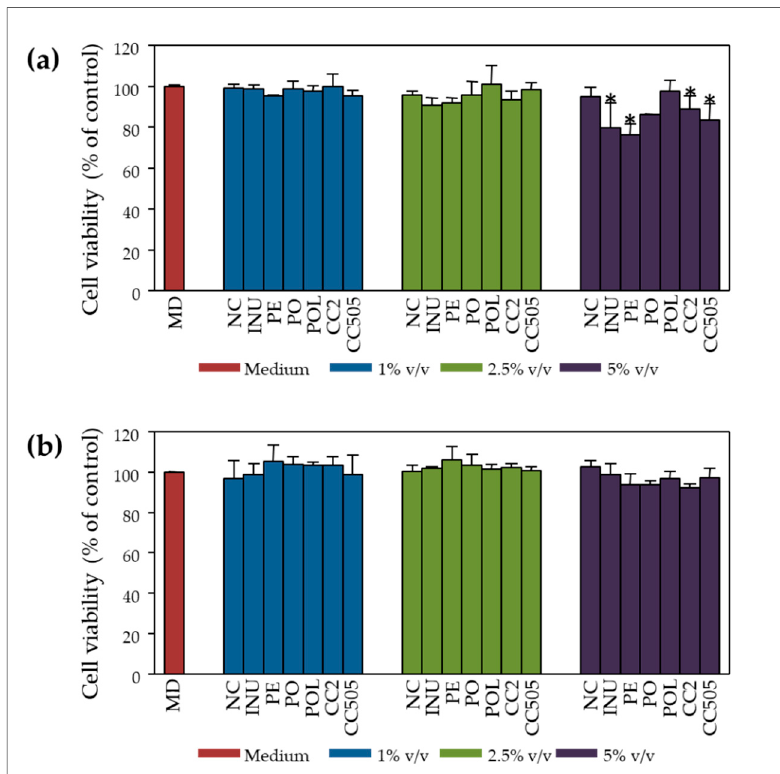
Figure 4. Inhibition of cell proliferation by pre- and post-fermentation supernatants (FSs): Caco-2 cells were treated with 1%, 2.5% and 5% v / v of ( a ) pre-fermentation (t = 0 h) and ( b ) post-fermentation (t = 24 h) supernatants of selected mushrooms for 48 h. Cells treated with medium only served as control (MD). NC: basal medium with no additional carbohydrate source, INU: inulin, PO: P. ostreatus strain 1123, POL: P. ostreatus strain LGM 22, PE: P. eryngii strain LGAM 216, CC2: C. cylindracea strain CC2, CC505: C. cylindracea strain 505. Faecal inocula derived from 8 donors and the fermentation supernatants were pooled for this process. All values are expressed as the mean ± SD of at least two independent experiments. * p < 0.05 versus control / non-treated cells. Associations were not significant unless otherwise indicated.